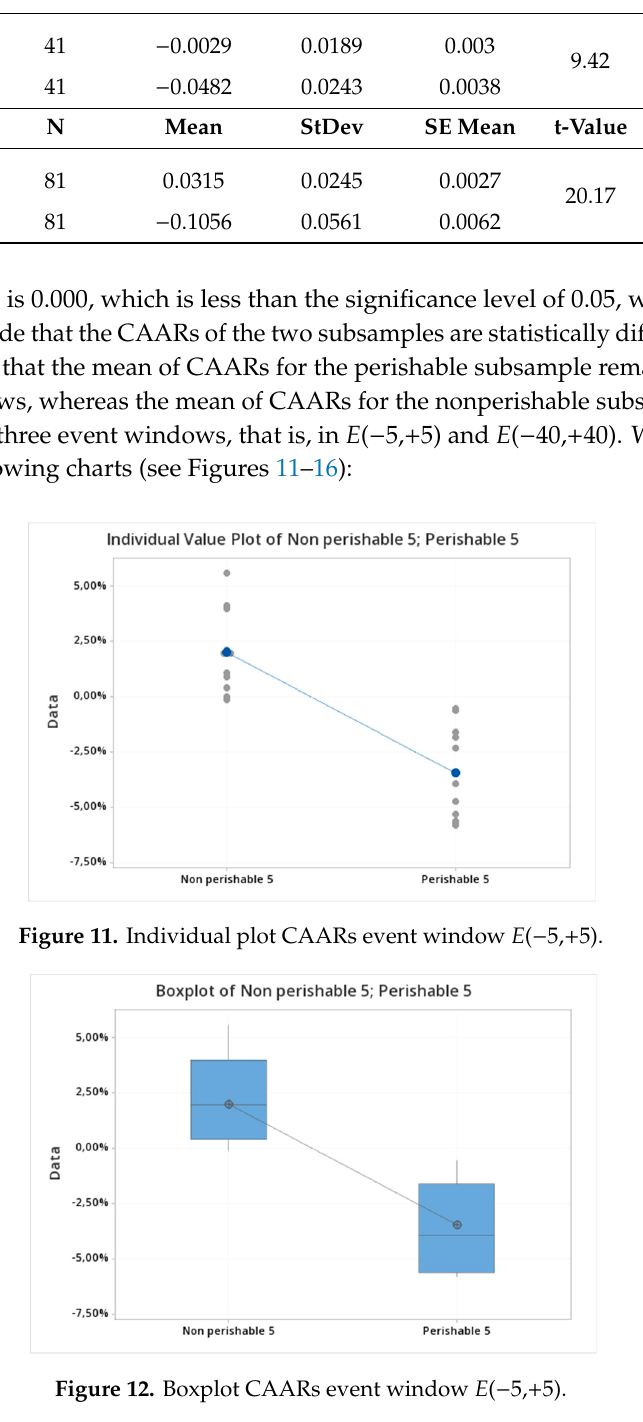
. Figure 13. Individual plot CAARs event window E ( − 20,+20) .